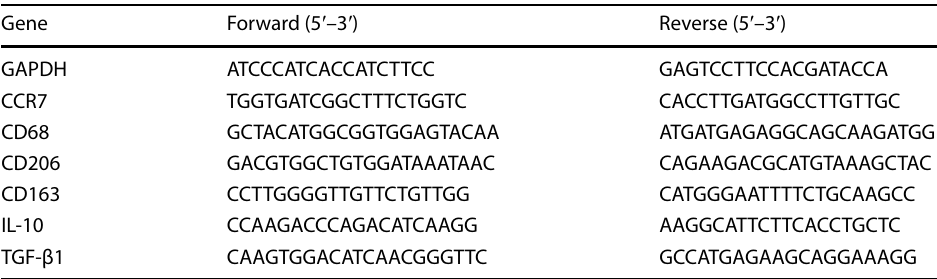
Table 1 Primers used for